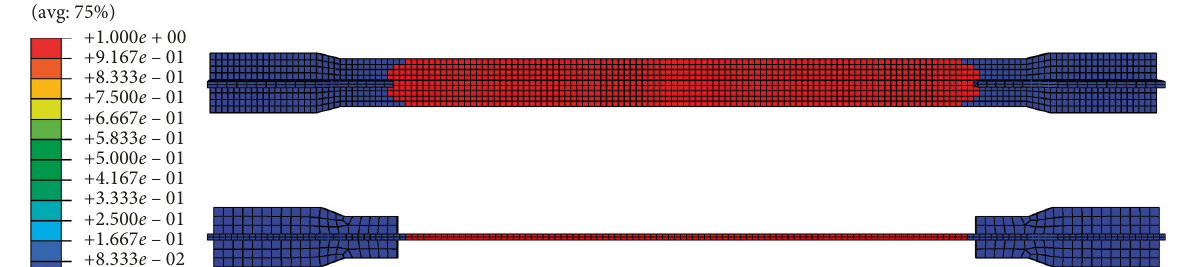
Figure 17: AC yield of the BRB-TJ-I core ( δ